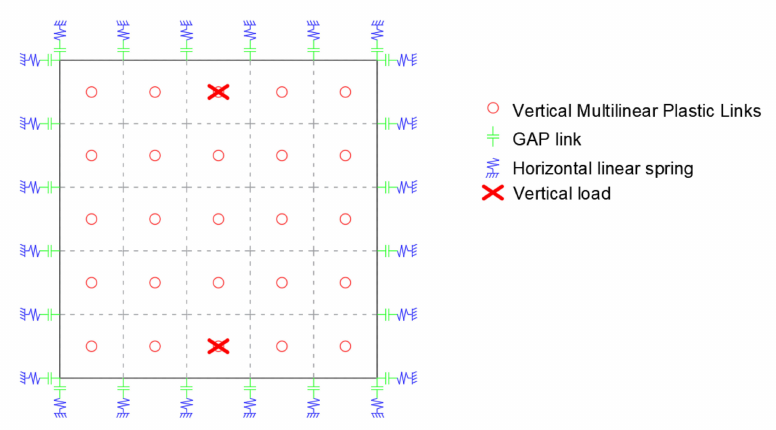
Figure 4. Scheme of the numerical model of the foundation